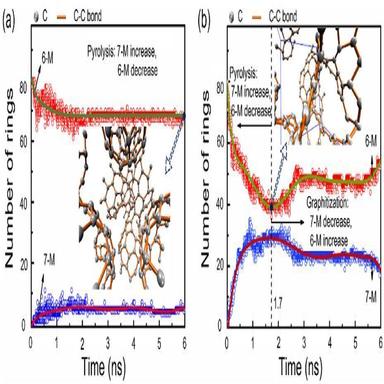
The pore size distribution (PSD) diagrams with time in the C60 conversion products. The results were obtained by using a probe with a diameter of 0.5 Å.